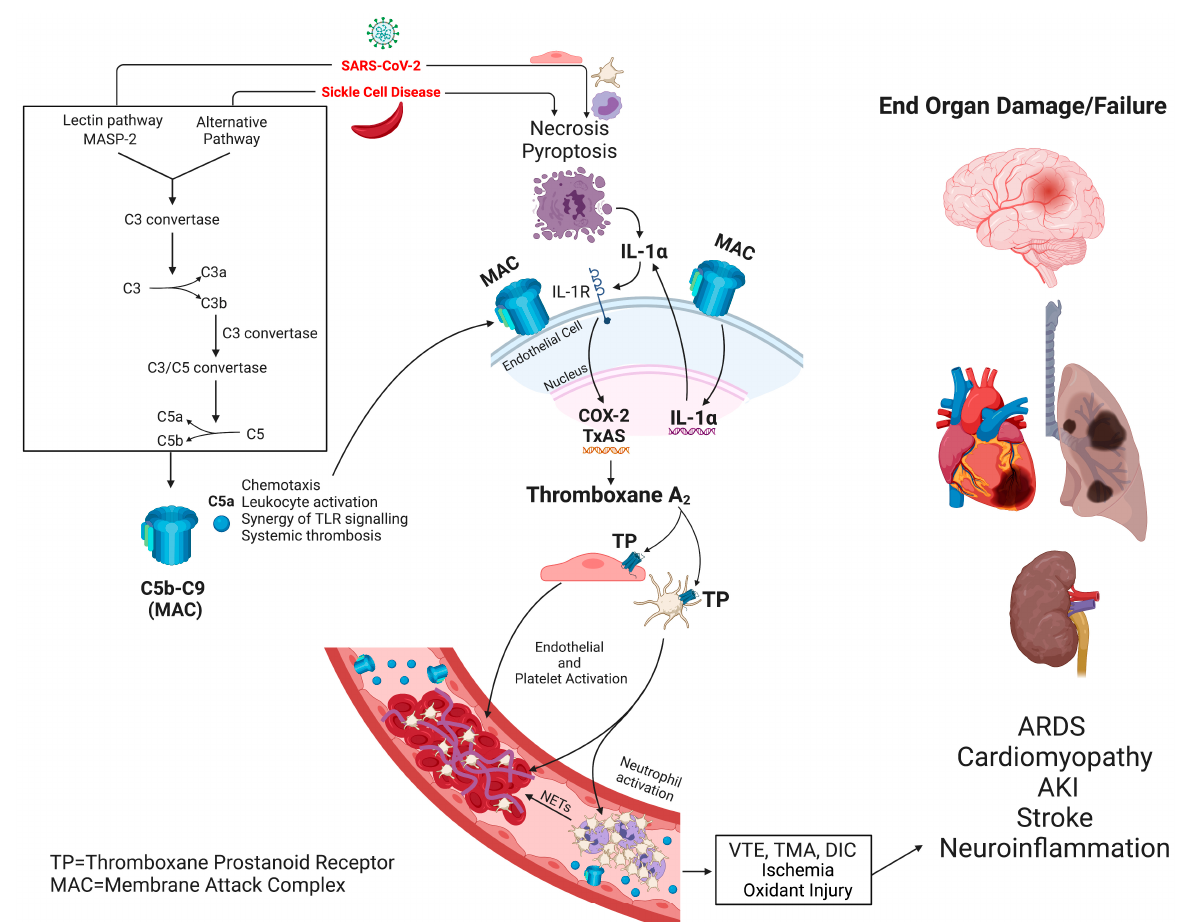
Figure 1. Putative mechanism of complement-mediated microvascular thrombosis and vaso-occlusive disease in SCD and COVID-19: SARS-CoV-2 infection and sickle cell disease induce complement activation and formation of membrane attack complex leading to necrosis and pyroptosis of endothelial cells, platelets, and monocytes and accumulation of IL-1 α . IL-1 α stimulates the IL-1 receptor expressed on endothelial cells leading to thromboxane synthesis. Thromboxane A 2 via the TP receptor activates platelets leading to platelet activation, platelet neutrophil partnership, neutrophil activation, and the release of neutrophil extracellular traps (NETs), thrombo-inflammation, oxidative stress, and subsequent end-organ damage and failure. The current review article is primarily focused on eicosanoid signaling in platelets; therefore, other receptors and pathways were excluded from Figure 1 for the reader’s convenience. COX, cyclooxygenase; IL, interleukin; NETs, neutrophil extra- cellular traps; TP, thromboxane prostanoid receptor; MAC, membrane attack complex; VTE, venous thromboembolism; TMA, thrombotic microangiopathy; DIC, disseminated intravascular thrombosis; ARDS, acute respiratory distress syndrome; AKI, acute kidney